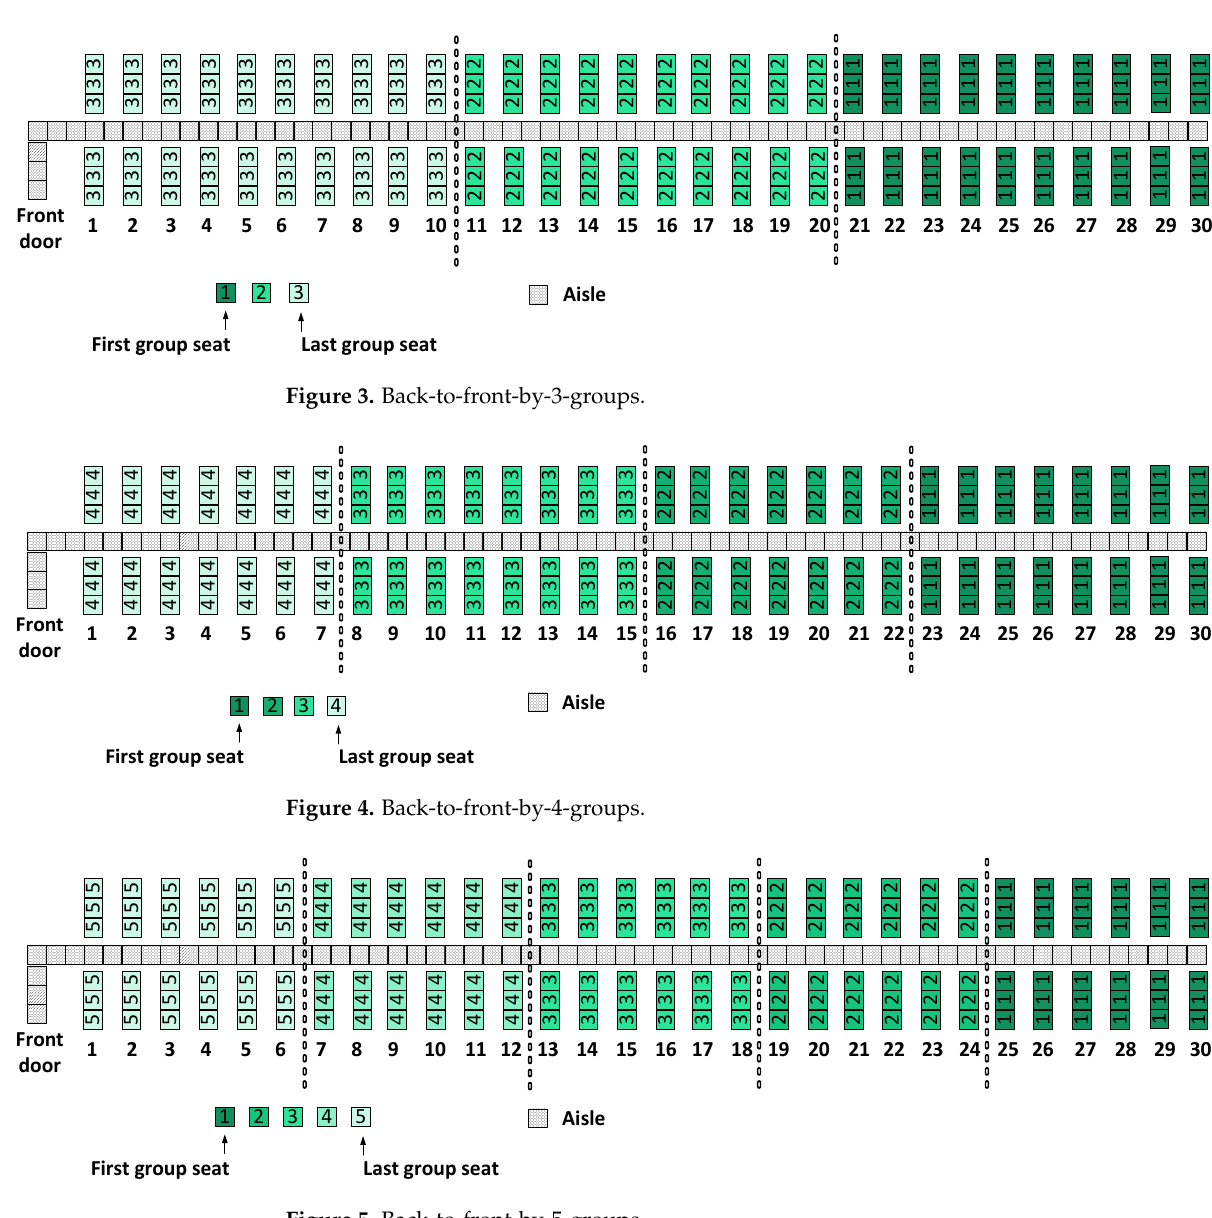
Figure 5. Back-to-front-by-5-groups. Figure 5. 2.5. Back-to-Front-by-Row Boarding Method In the back-to-front-by-row boarding method, the first group of passengers to board are located in the row closest to the rear of the airplane. The next group has the seats in the second-to-last row of the airplane. The final group to board has the seats in the first row of the airplane. Figure 6 presents the boarding scheme for this method, wherein 30 groups (one per row) are called to board in sequence. Each of these groups has six pas- sengers.